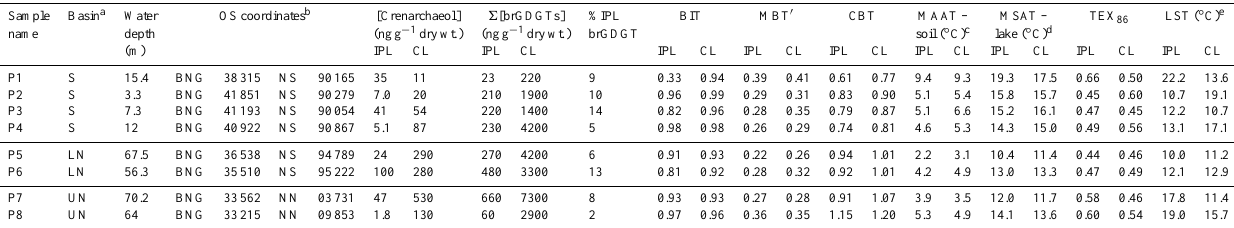
Table 5. Surface sediment data: crenarchaeol and summed brGDGT concentrations, BIT indices, MBT 0 indices, CBT ratios, TEX 86 indices, inferred mean annual air temperatures (MAATs), inferred mean summer air temperatures (MSATs) and inferred lake surface temperatures